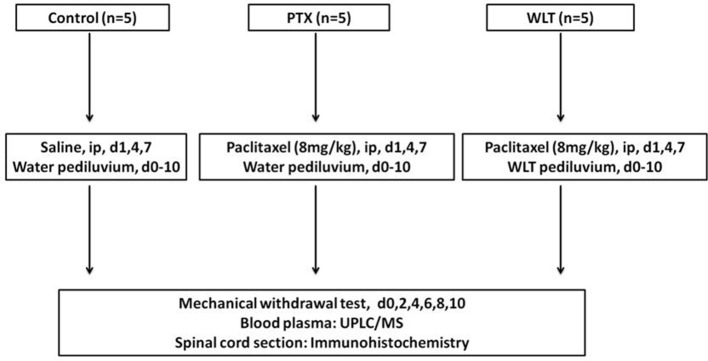
Experimental design. Animals of Control, PTX and WLT received paclitaxel/saline injection and WLT/water pediluvium during the experiment. The PIPN model was constructed by administration of paclitaxel at 8 mg/kg by intraperitoneal injection on d1, 4, 7. WLT solution was given tropically by pediiluvium twice a day for 11 consecutive days (d0-10). The behavior assay was monitored every other day (d0, 2, 4, 6, 8, 10). The rats were finally euthanized on day 10. Plasma and spinal cord samples were collected for preparation and analysis.